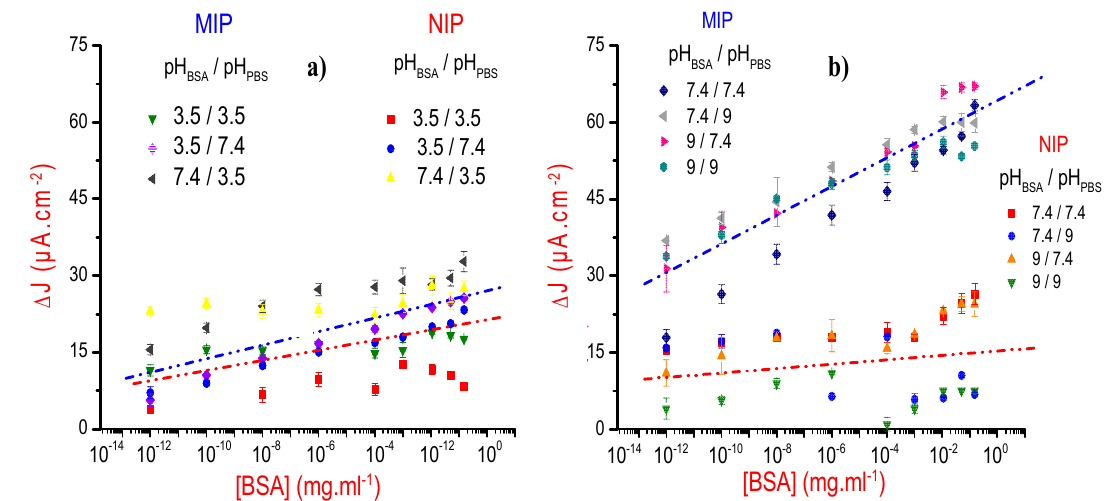
Figure 6. Variations of the current densities, ∆ J MIP and ∆ J NIP versus cumulative BSA concentration (in semilogarithmic representation): ( a ) For (pH BSA or pH PBS ) lower than BSA isoelectric point (IP). ( b ) For (pH BSA and pH PBS ) higher than BSA IP.